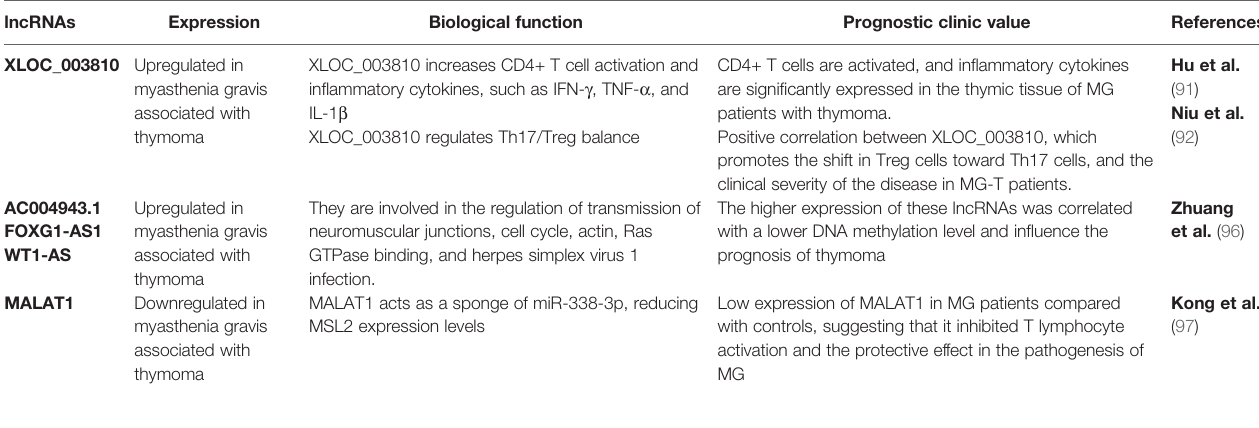
TABLE 2 | LncRNAs deregulated in Myasthenia